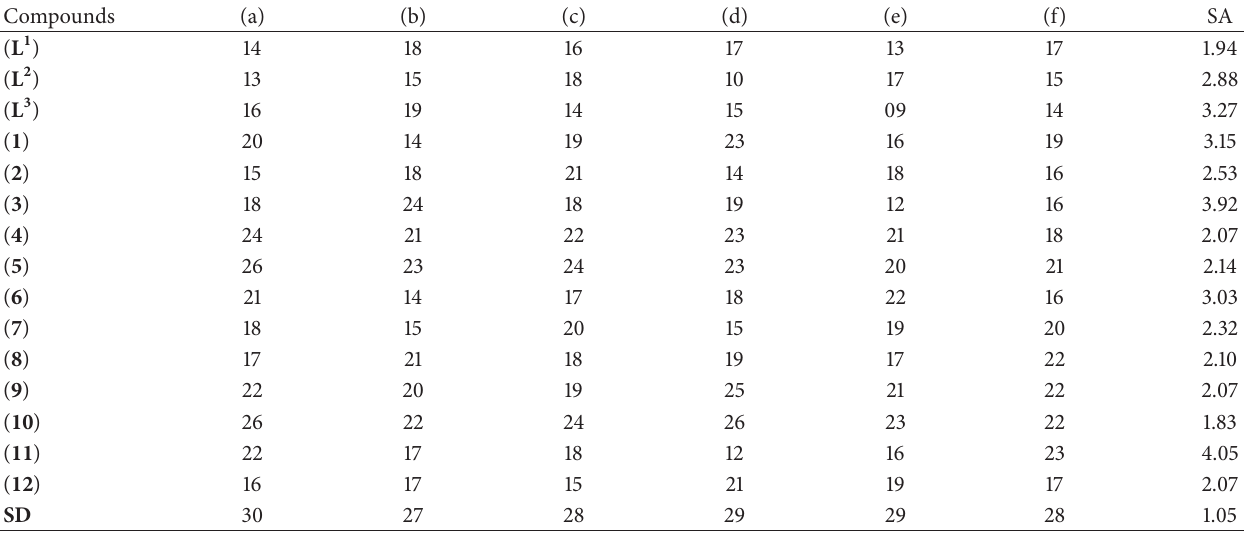
Table 1: Antibacterial bioassay of ligands and their metal(II) complexes (zone of inhibition in mm).